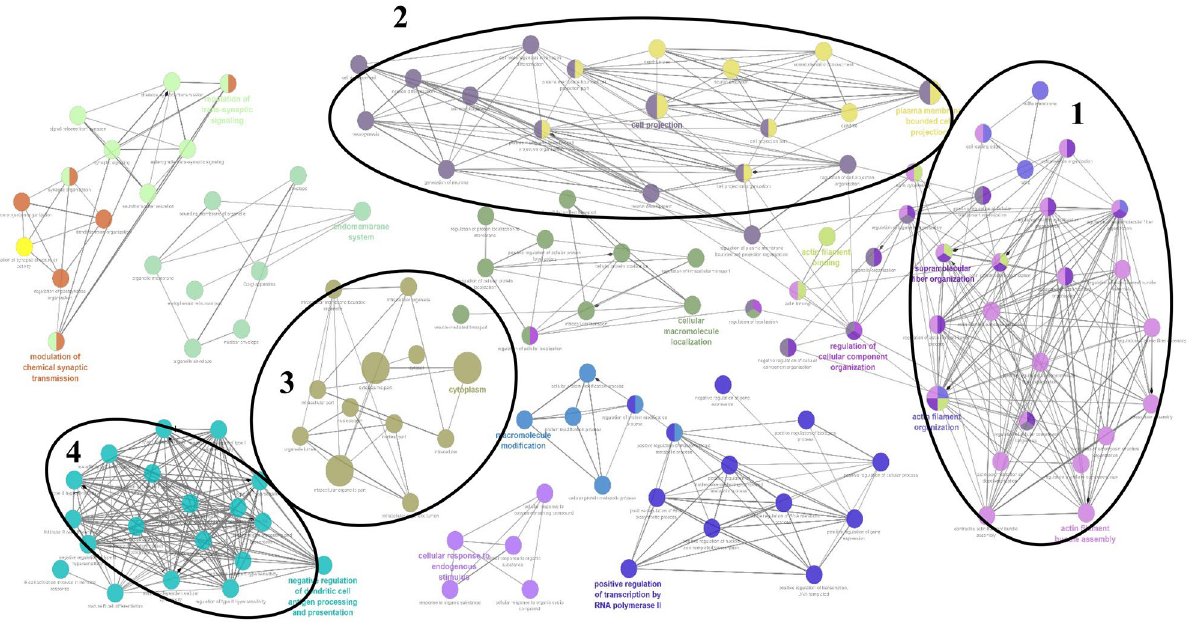
Figure 7. Gene-network interactions between all the genes reported in the orthologous areas of H. sapience , for the genomic regions containing CNVRs in Afghan sheep breeds [the figure developed by Cytoscape